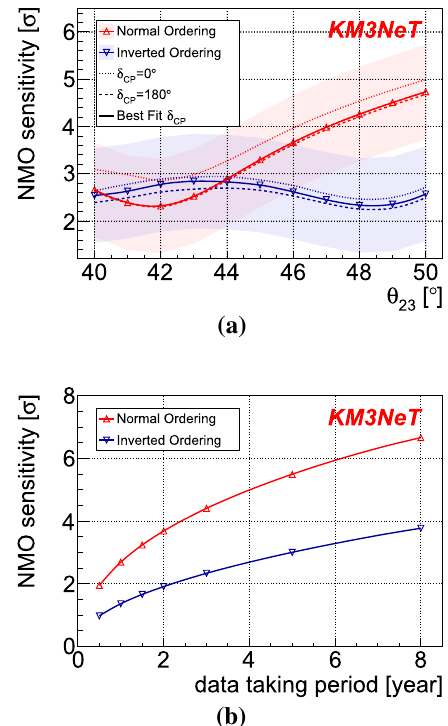
Fig. 10 Expectedmeasurementprecisionof Δ m 2 and θ 23 forbothNO 32 ( a ) and IO ( b ) after 3 years of data taking at 90% confidence level (red) overlaid with results from other experiments [10–14] and the oscillation parameters reported in Table 2 (black cross) , θ 23 ) plane are excluded with 90% confidence ( Δ m 2 32